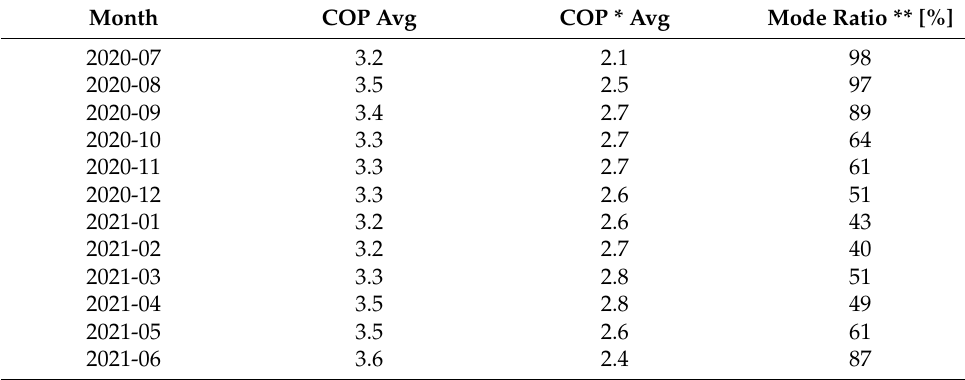
Table 5. Heat pump system: average